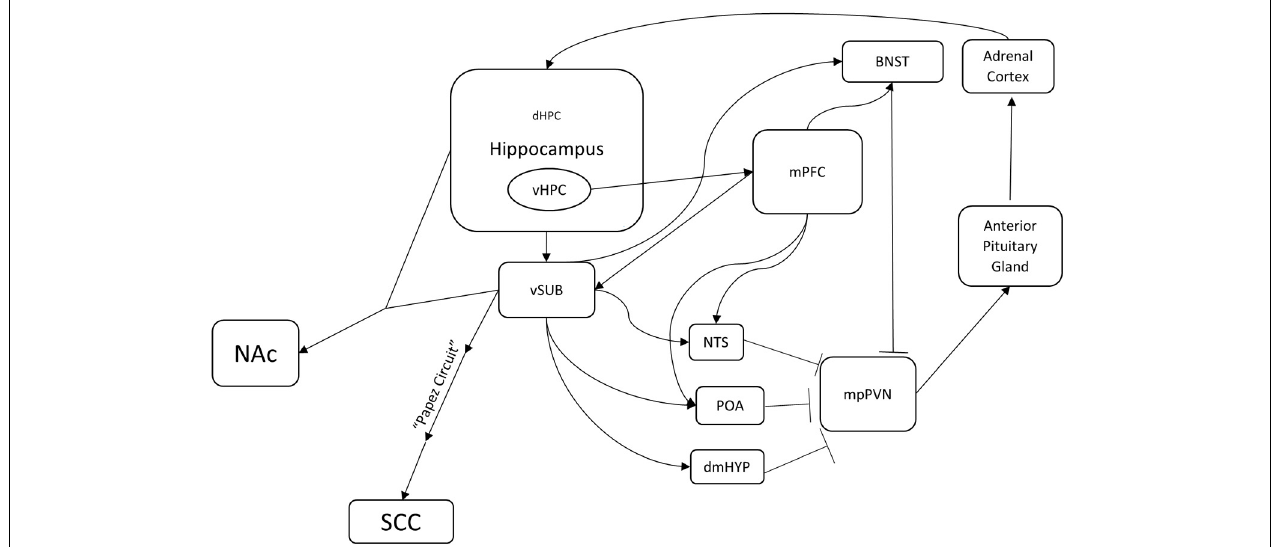
FIGURE 1 | A potential hippocampus-based neural circuit for TRD. Several distinct neural circuits likely underlie resistance to traditional antidepressants. This is one potential hippocampus-based circuit. The hippocampus regulates the HPA axis (mpPVN > Anterior Pituitary Gland > Adrenal Cortex) through multiple brain nuclei. Medial parvocellular paraventricular nucleus (mpPVN) neurons receive inhibitory inputs from the bed nucleus of the stria terminalis (BNST), the dorsomedial hypothalamus (dmHYP), the preoptic area (POA), and the nucleus of the solitary tract (NTS). In turn, these areas receive excitatory inputs from the ventral subiculum (vSUB) and the medial prefrontal cortex